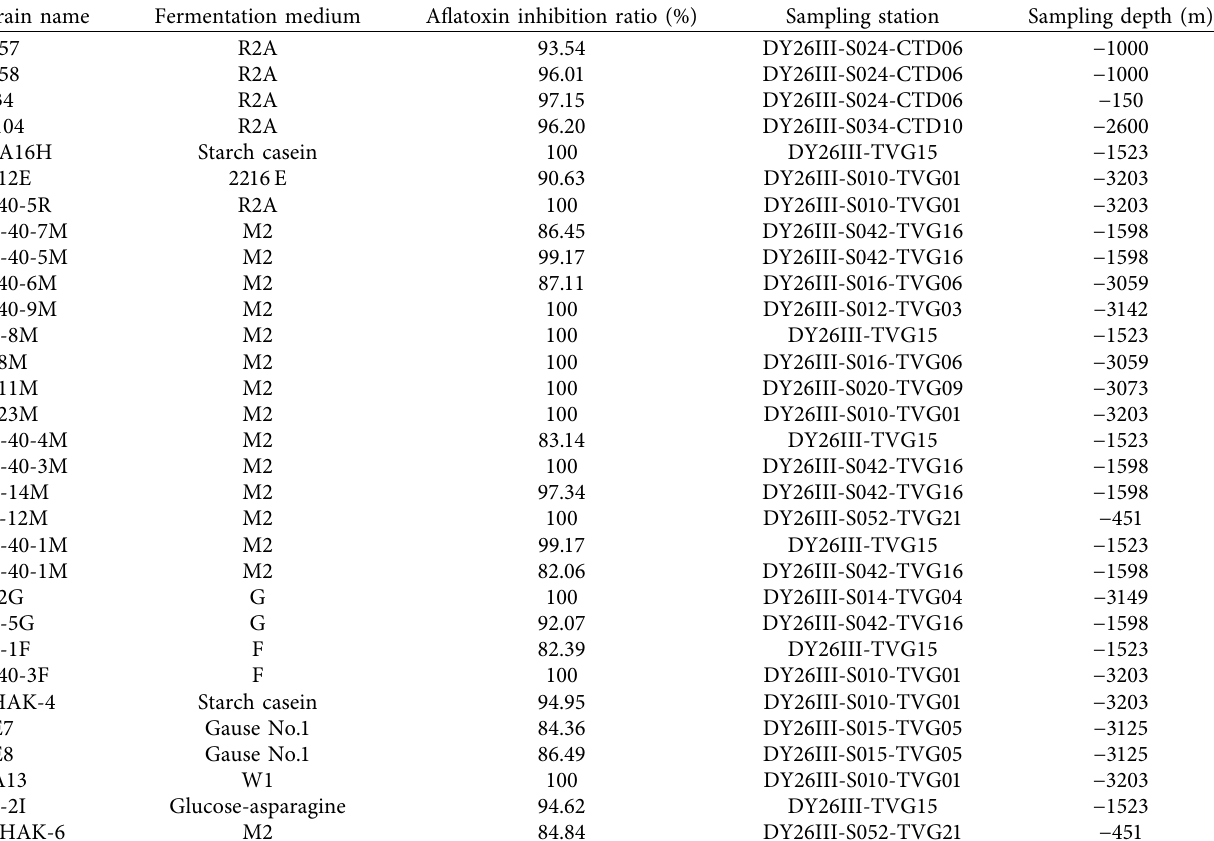
Table 3: Fermentation medium, aflatoxin inhibition ratio, sampling station, and sampling depth for each strain.